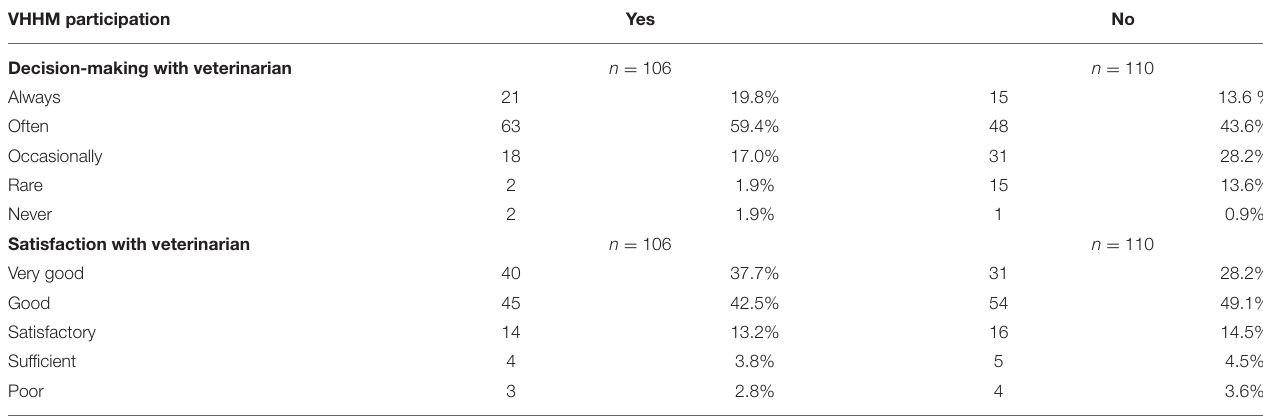
TABLE 3 | Decision-making and satisfaction with